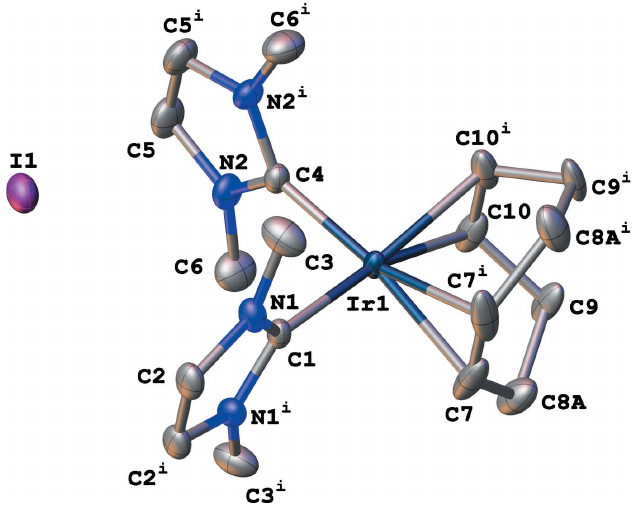
Figure 2 Displacement ellipsoid plot (50% probability) of ( (cid:2) 4 -cycloocta-1,5-